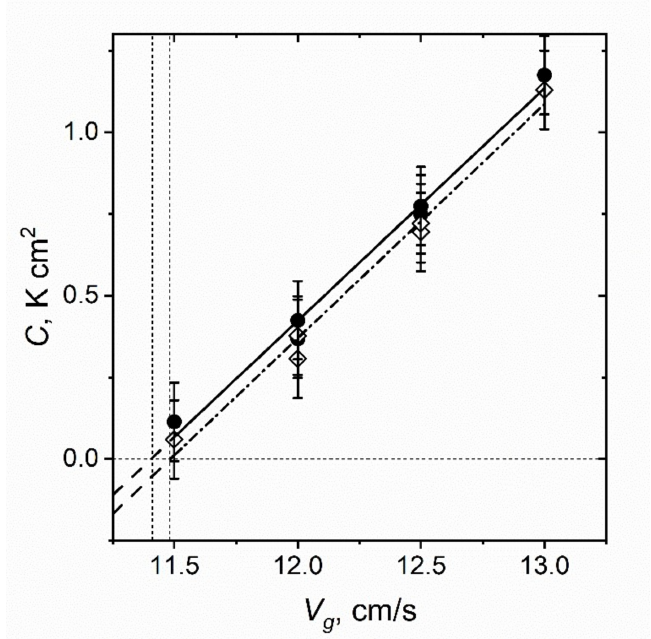
Figure 2. Determination of laminar burning velocity for a flame at φ = 0.65, using the mean of C coefficients at around 175 s (open symbols and dash-dotted line) and extrapolated C (closed symbols and solid line). Error bars include uncertainties in C as a result of thermocouple scatter.